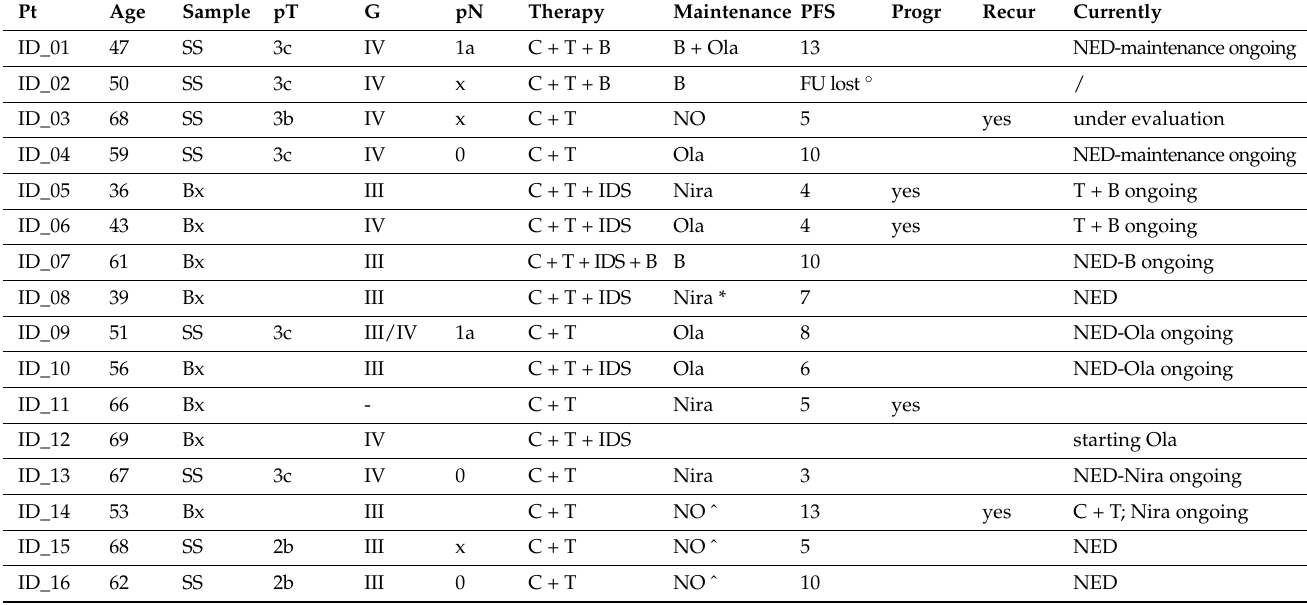
Table 1. Patients’ clinicopathological